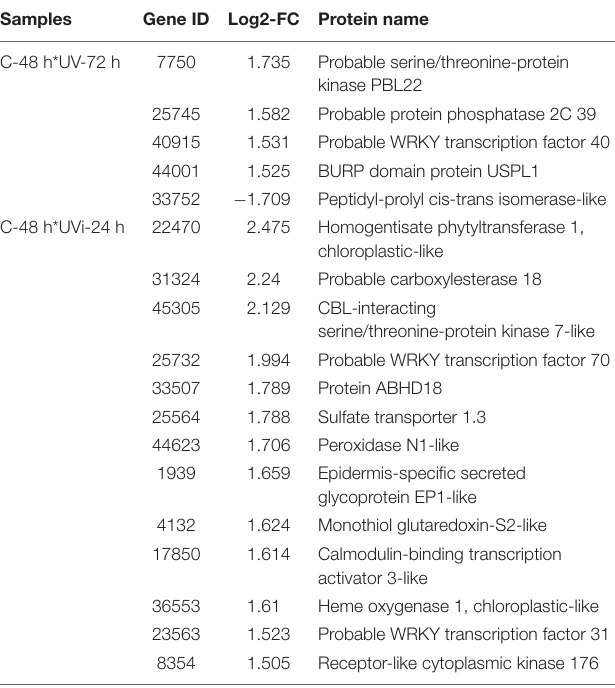
TABLE 2 | Relative expression of stress and antioxidant response